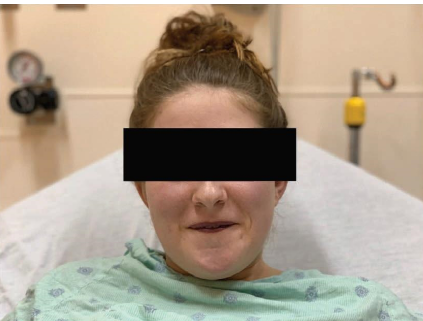
Figure 1: Our patient presented with the blue/purple shade of skin characteristic of congenital methemoglobinemia.